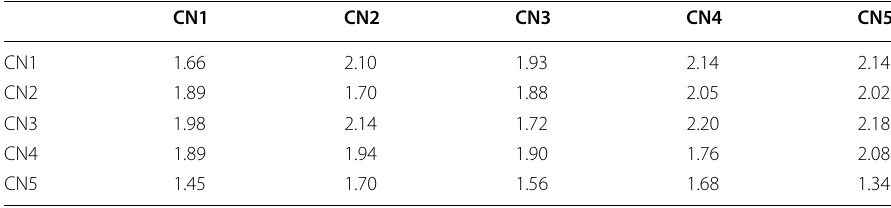
Table 19 Defuzzified values of TRM